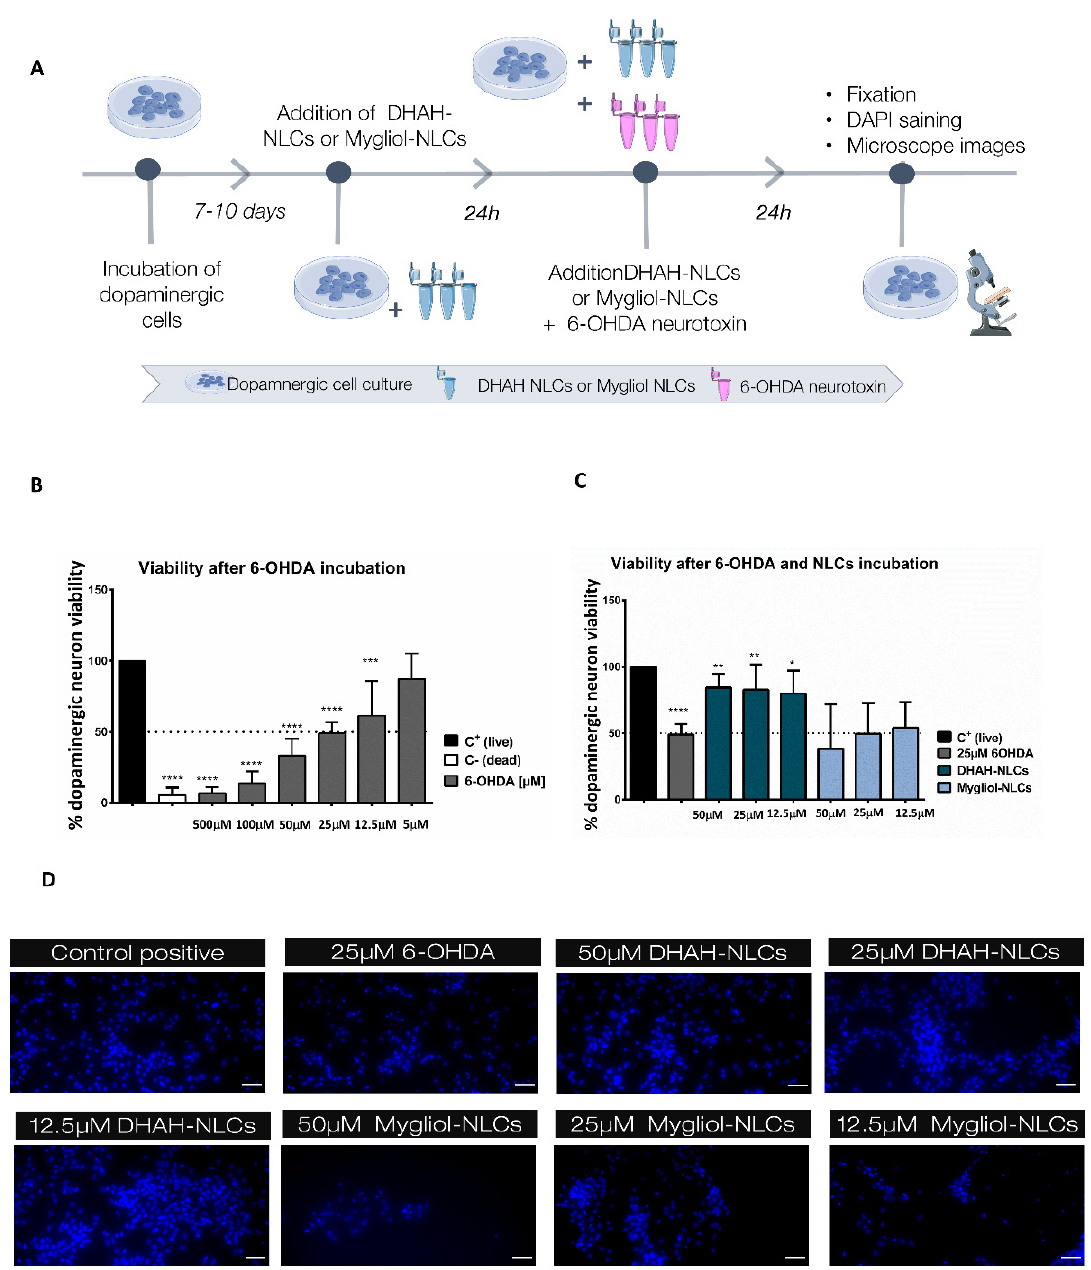
Figure 2. ( A ) Schematic representation of dopaminergic cell-based assays to evaluate the neuroprotective effects of DHAH-NLCs and Mygliol-NLCs. This figure was created using Servier Medical Art templates, which are licensed under a Creative Commons Attribution 3.0 Unported License (https://smart.servier.com). ( B ) Graphic representation of dopaminergic neuron viability after 24 h of incubation with different doses of 6-OHDA (**** p < 0.0001 C + vs C − , 500 µM, 100 µM and 25 µM *** p < 0.001 C + vs 10 µM); one-way ANOVA. ( C ) Graphic representation of the neuroprotective effect of DHAH-NLCs (** p < 0.01 25 µM 6-OHDA vs 50 µM DHAH-NLCs and 25 µM DHAH-NLCs, * p < 0.05 25 µM 6-OHDA vs 12.5 µM DHAH-NLCs); one-way ANOVA. ( D ) Representative fluorescence images of the neuroprotective assay with DAPI staining. The scale bar indicates 50 µM.